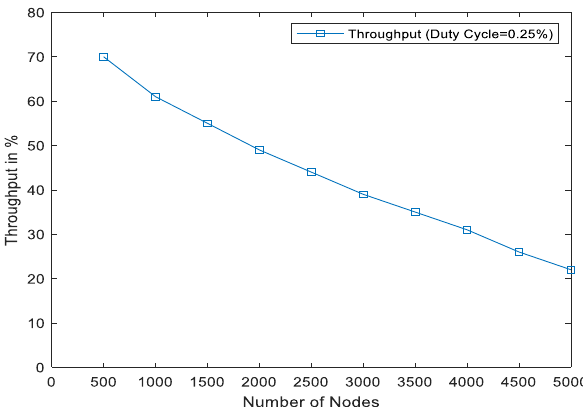
Figure 4: Throughput of the network in presence of di ff erent nodes with duty cycle of